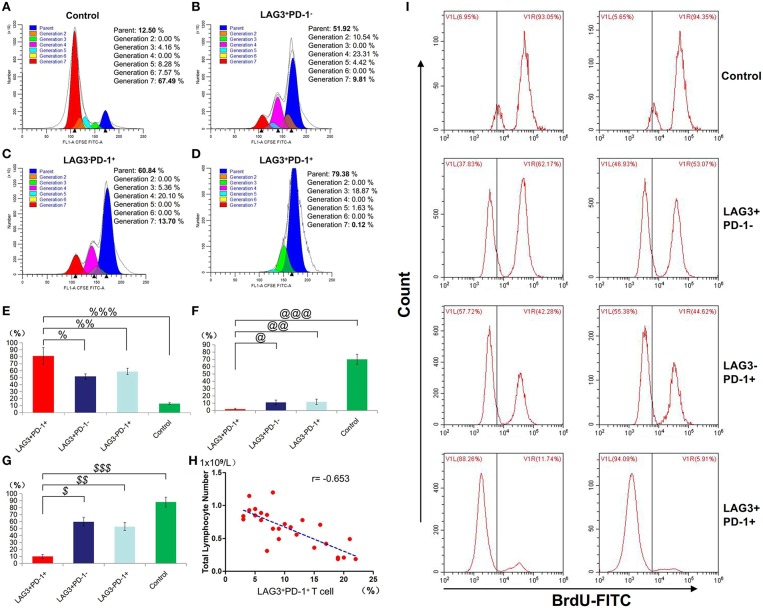
Determination of the proliferation of T cells with double- or single-positive expression of LAG3 and PD-1. After the sorting and culturing described above, we used two methods, CFSE (A–F) and FITC-Brdu (G) staining, to consistently evaluate the proliferative capacities of T cells with different phenotypes. From the division and proportional analysis, we found that the proliferation of LAG3+PD-1+ T cells was obviously inhibited (A) compared with that of LAG3+PD-1− T cells (B), LAG3−PD-1+ T cells (C), and control T cells (D), with the highest proportion of cells remaining in the parental generation (%P < 0.05, %%P < 0.05, and %%%P < 0.05) (E) and the lowest proportion of cells appearing in the seventh generation (@P < 0.05, @@P < 0.05, and @@@P < 0.05) (F). The analysis of FITC-Brdu staining showed similar results, with the proliferation rates of LAG3 and PD-1 double-positive T cells being the lowest ($P < 0.05, $$P < 0.05, and $$$P < 0.05) (G). The proportion of coexpressing T cells was negatively correlated with the total number of lymphocytes using Pearson's simple correlation coefficient (r = −0.653, 95%CI: −0.831 to −0.356, P = 0.0003) (H). Data of (E–G) are expressed as the mean ± SEM, and compared with ANOVA. Representative pictures of flow cytometry using BrdU-FITC to detect the proliferation rates of T cells with different phenotypes (I).